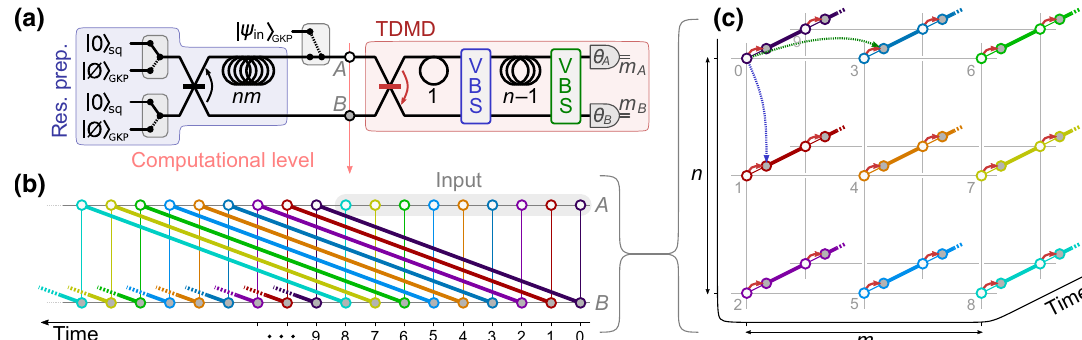
FIG. 2. (a) Temporally encoded computational setup for our scheme. The scheme consists of three parts: the resource-preparation gadget; the computational level, where the computation takes place; and the temporally delocalized measurement device (TDMD) for gate implementation by projective measurements. This scheme utilizes temporal multiplexing of two spatial modes, A and B , marked in the computational level. (b) Wires of two-mode entanglement at the computational level shown in the time domain, here for the simple case of nm = 9. The bold lines represent two-mode entanglement, while the thin lines indicate the temporal overlap of A and B . The wires begin with nm input states in temporal modes 0 to 8, switched in using an optical switch in A in the computational level. The colors of the wires have no physical meaning and are used merely to indicate different wires. (c) Wires rearranged into a 3D time lattice, where the input is encoded onto the n × m end surface, while gates are implemented by teleportation along the wires in the third dimension. Here, the red arrows represent the first beam splitter of the TDMD, while the dotted blue and green arrows represent the variable beam splitters of the TDMD. The first ten temporal modes in (b) from 0 to 9 are labeled in (c). (marked in Fig. 1 with a red arrow) and two